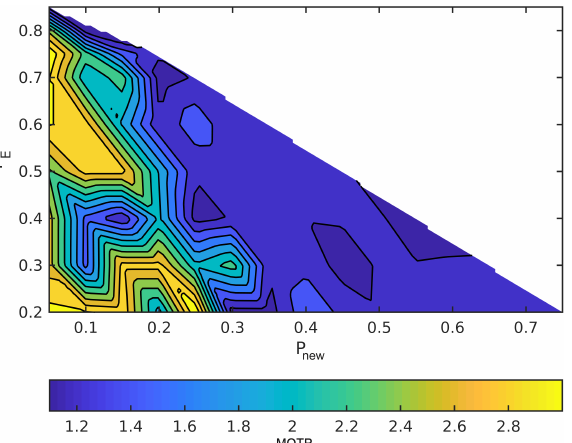
Figure 7. Simulate the effect of different sets of probabilities on MOTP with static VRUs and with one meter measurement noise.